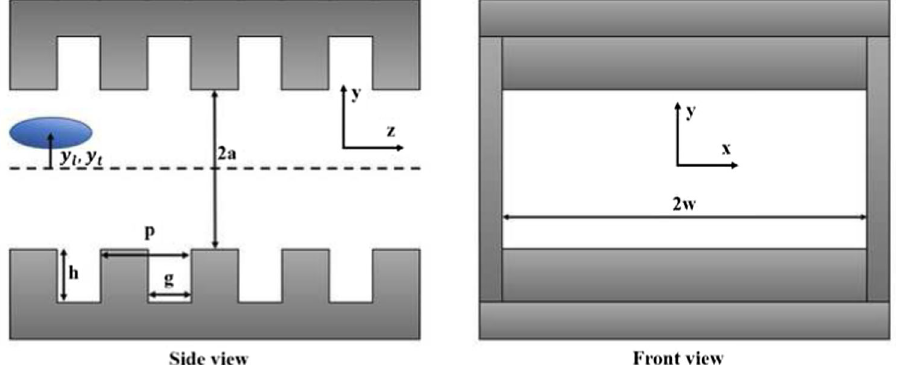
FIG. 1. Geometry of the corrugated-wall dechirper [1,2]. The blue ellipsoid indicates a beam bunch moving parallel to the z -axis with a transverse offset.